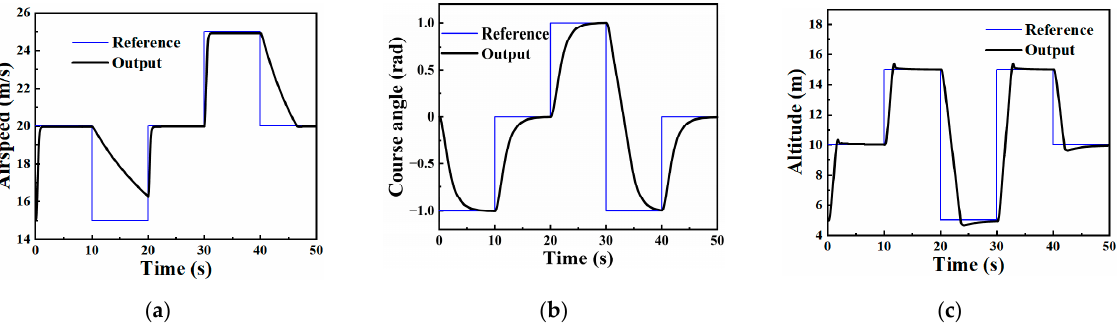
Figure 22. Responses of the UAV under different commands: ( a ) airspeed; ( b ) course angle: ( c ) altitude. Table 7. Transient step response parameters for the stability controller.